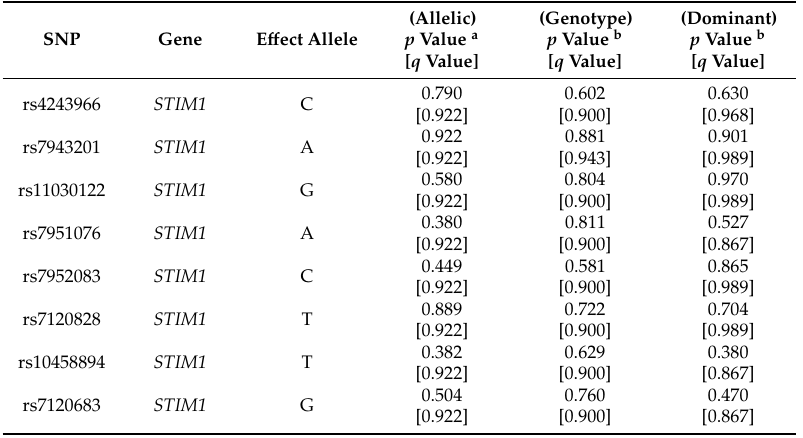
Table 3. Association of STIM1 and ORAI1 genes with hepatocellular carcinoma in hepatitis B virus (HBV) patients under allelic, genotypic, and dominant